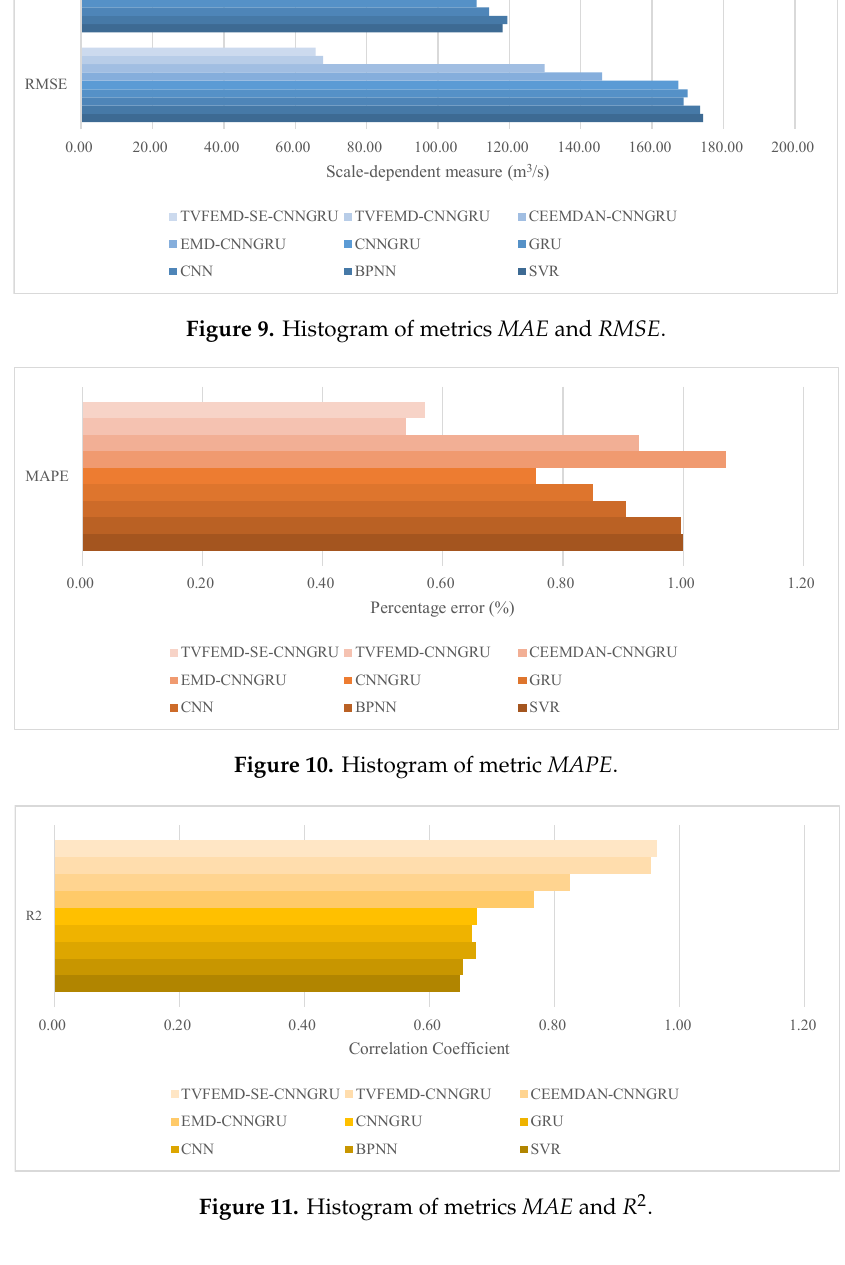
Figure 12. Taylor diagram for the visualized evaluation for all the models. Figure 13. Visualization of all the metric decline ratios.